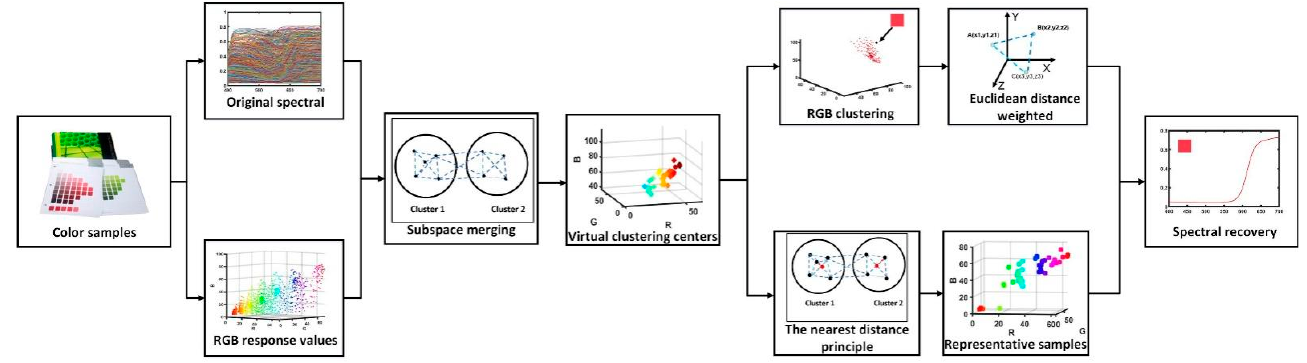
Figure 1. Schematic illustration of the proposed method for spectral reflectance recovery.